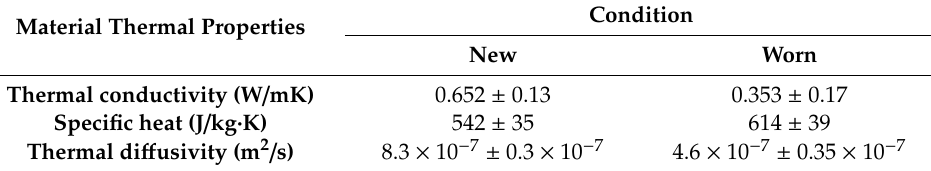
Table A2. Thermal transport properties for new and worn clutch lining material [21].